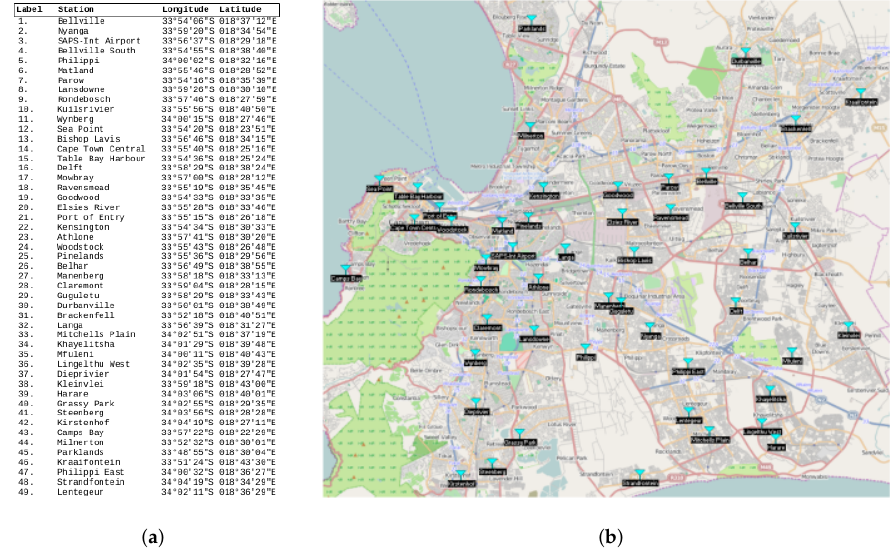
Figure A1. Raw real network study. ( a ) GPS positions of Cape Town police stations; ( b ) positions on the globe’s